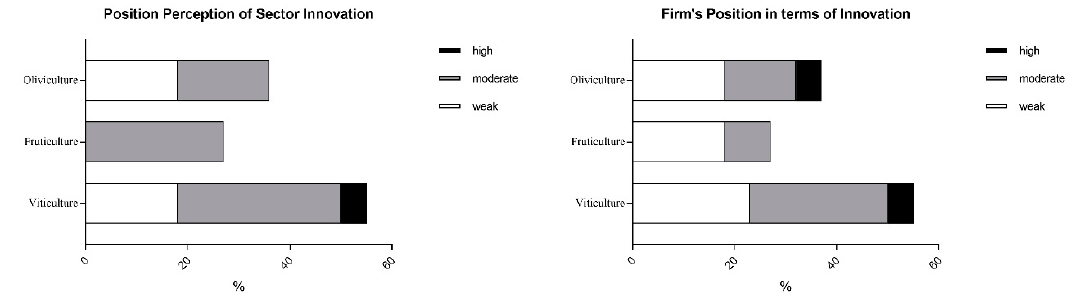
Figure 1. Innovation perception. Source: Author’s calculation from the research dataset.